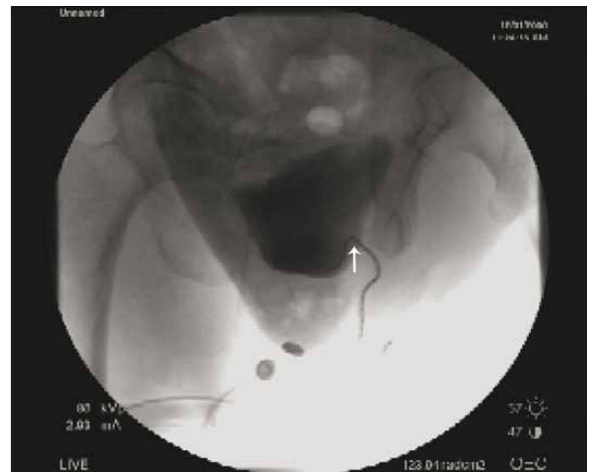
Figure 3 - Demonstrates chain angulation from a VCC test that is consistent with obstruction. White arrow shows chain angulation consistent with obstruction from patient with previous suburethral